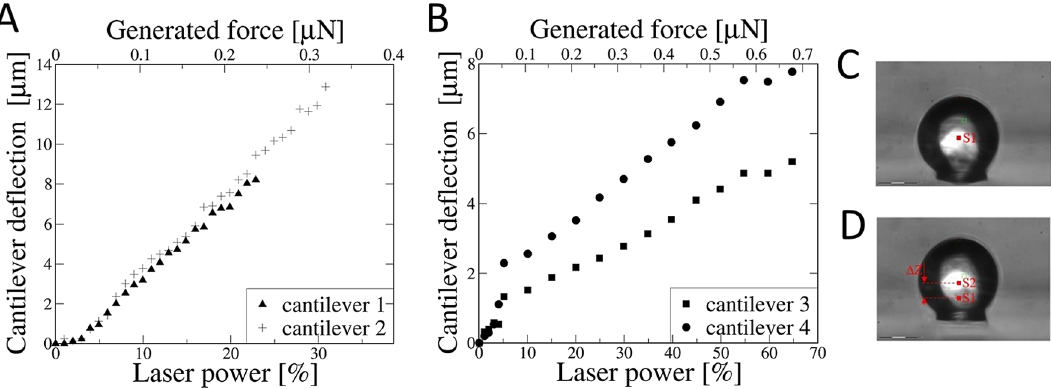
Figure 4. Cantilever deflection under the influence of increasing OT generated force for ( A ) rectangular cantilever (CSG10, NT-MDT) and ( B ) V-shape cantilever (PNP-TR-TL-SPL, NanoWorld). All cantilevers have been modified to colloidal probes. Particle position at lowest ( C ) and highest ( D ) applied laser power.